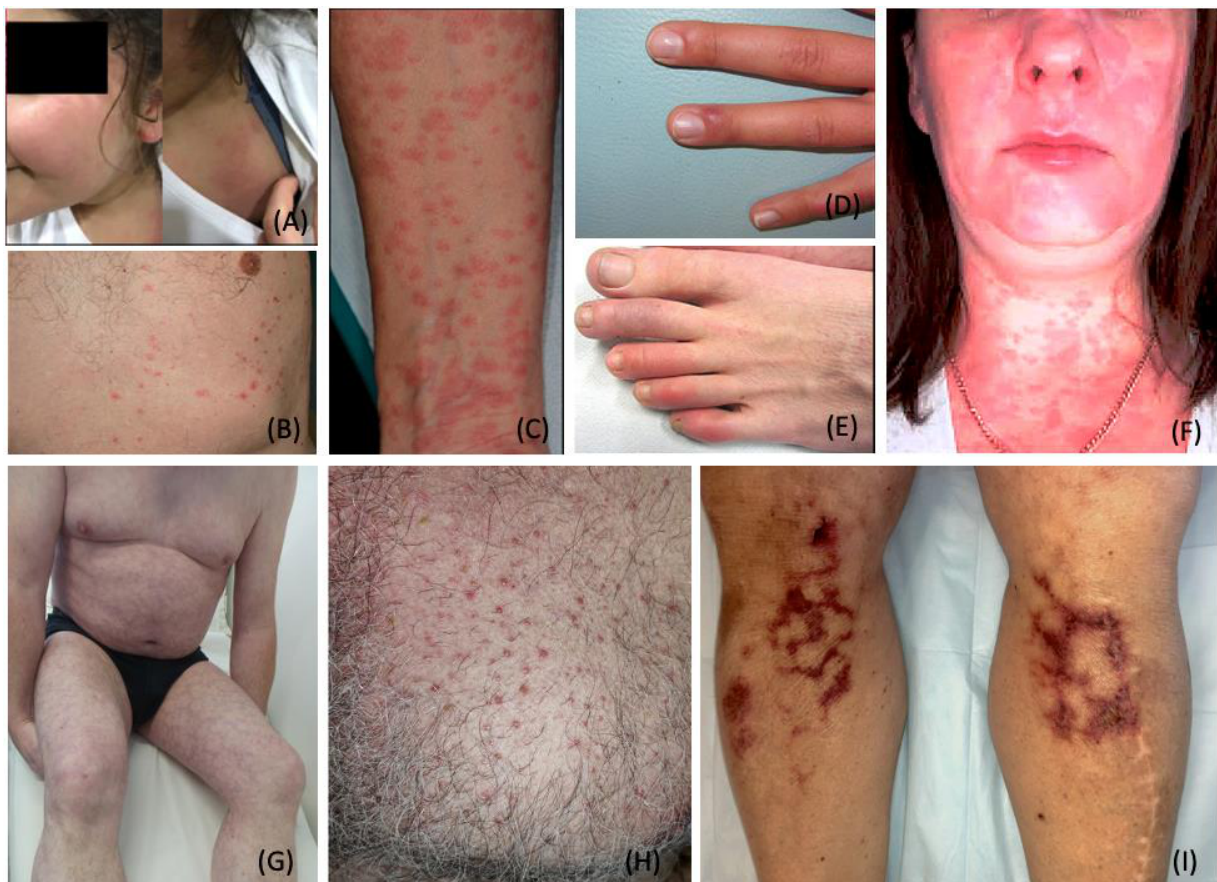
Figure 2. Cutaneous Manifestations Related to COVID-19 Infection. ( A ). Maculopapular rash observed on the face and shoulder of an 11-year-old child; ( B ). Varicella-like crusted papular lesions of the trunk; ( C ). Maculopapular lesions coalesced into small plaques on the anterior forearm; ( D , E ). Chilblains-like erythema of the fingers ( D ) and toes ( E ); ( F ). Urticarial erythematous eruption of the face, neck, and upper chest; note: no mild angioedema on the lower lip, due to excess interstitial fluid in the dermis and subcutaneous tissue; ( G ). Livedo reticularis: a symmetric regular lace-like network of the trunk and extremities ( H ). Monomorphic vesicles and pustules of the chest; ( I ). Retiform purpura of the lower extremities. Photo credit is acknowledged to the following original